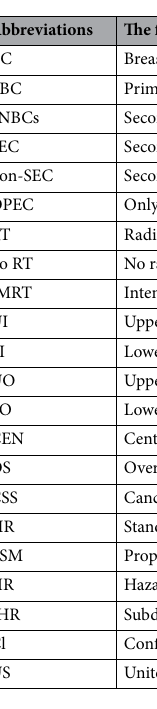
Table 1. A list of